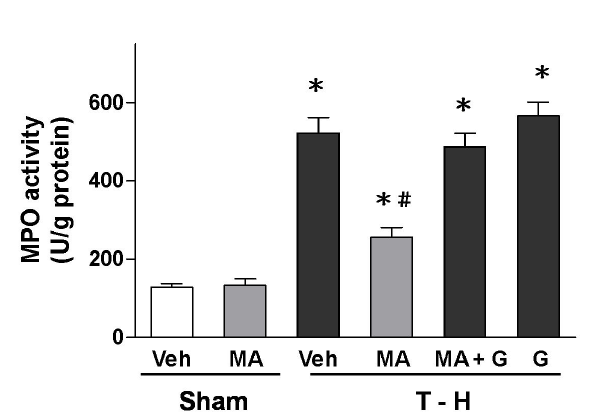
Figure 3. Effect of maraviroc treatment on hepatic MPO activity in rats at 24 hours after sham operation (Sham) or trauma-hemorrhage and resuscitation (T-H). Animals were treated with either vehicle (Veh), maraviroc (MA), maraviroc in combination with GW9662 (MA+G) or GW9662 (G). Data are shown as mean ± SEM of 8 rats in each group. * p <0.05 compared to Sham; # p <0.05 compared to T-H+Veh, T-H+MA +G, and T-H+G.